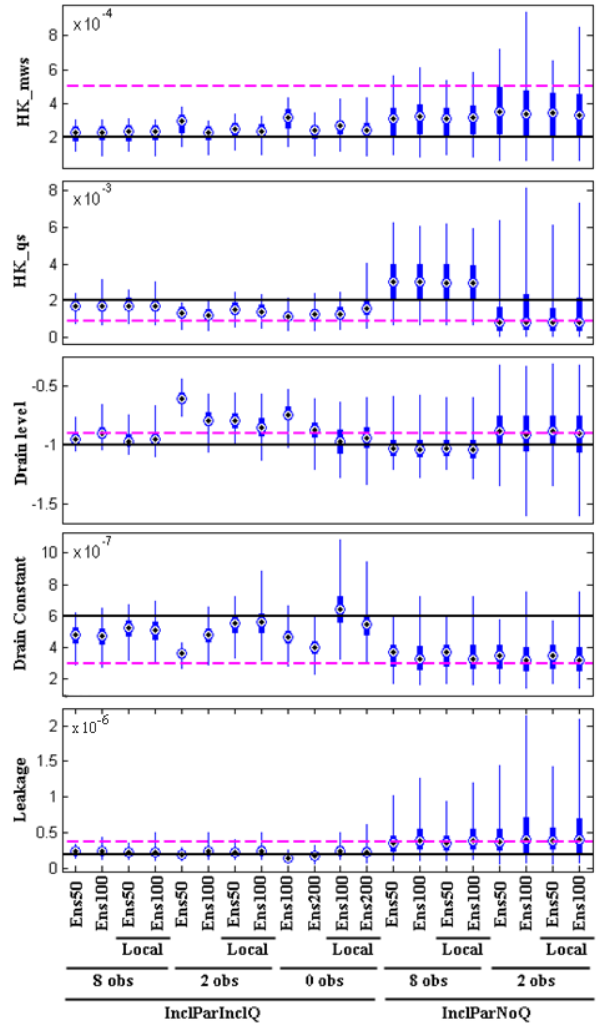
Figure 7. Spread of estimated parameters at the final update. Thin blue lines show the total spread of the ensemble and thick blue lines show the 25th and 75th percentiles. Dots show the mean of the en- semble. The horizontal lines show the true parameter value (black line) and the base parameter value (magenta